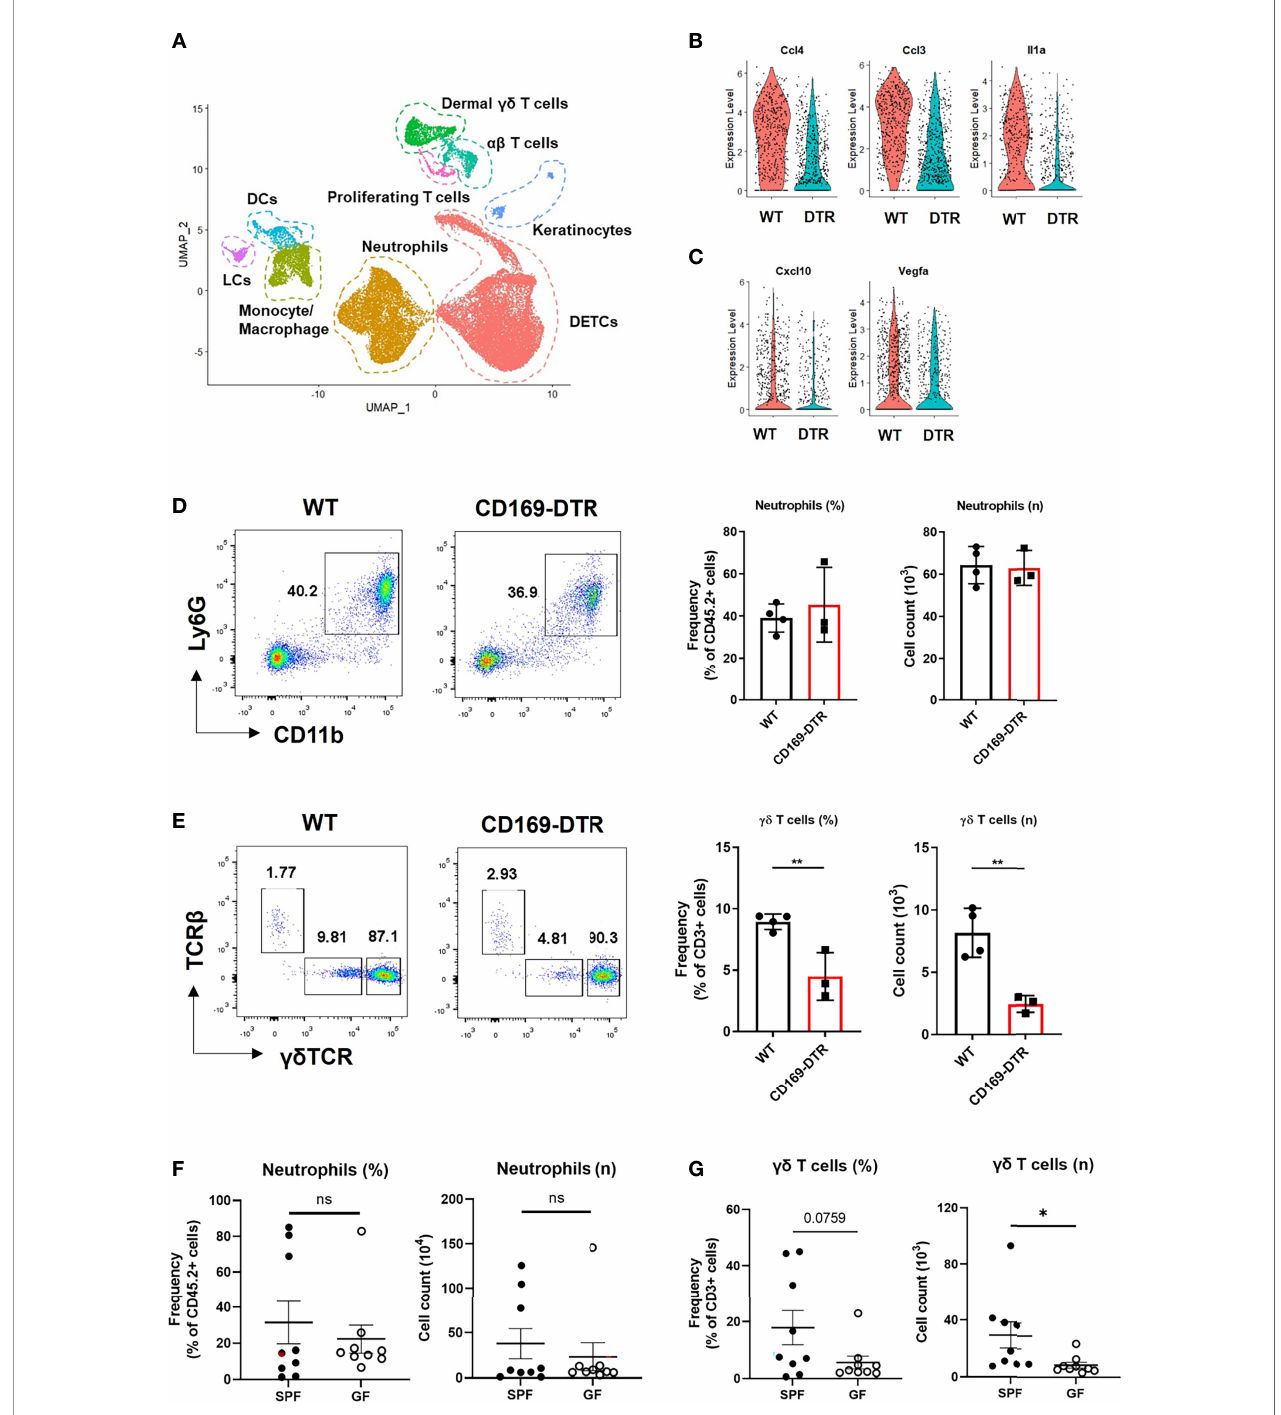
FIGURE 5 | gd T cells, not neutrophils, are affected by an absence of CD169+ cells at late time points. (A) UMAP projections of all skin-in fi ltrating immune cells. (B, C) Violin plot showing DEGs between WT and CD169-DTR of monocyte/macrophage cluster on day 2 (B) and day 5 (C) . (D, E) Flow cytometry analysis of neutrophils (D) and dermal gd T cells (E) in WT (n = 4) and CD169-DTR (n = 3) mice skin at day 6 post infection. The cells are gated on FSC/SSC, singlet, PI - , CD45.2 + (D) and FSC/SSC, singlet, PI - , CD45.2 + , CD3 + , CD11b -tolo (E) cells. Data are representative of three experiments. (F, G) Flow cytometry analysis of neutrophils (F) and dermal gd T cells (G) in SPF (n = 9) and GF (n = 9) mice skin at day 6 post infection. The cells are gated on FSC/SSC, singlet, PI - , CD45.2 + (F) and FSC/SSC, singlet, PI - , CD45.2 + , CD3 + , CD11b -tolo (G) cells. Representative data of two independent experiments are shown. Data are expressed as means ± SEM (*p < 0.05, **p < 0.01, ns, not signi fi